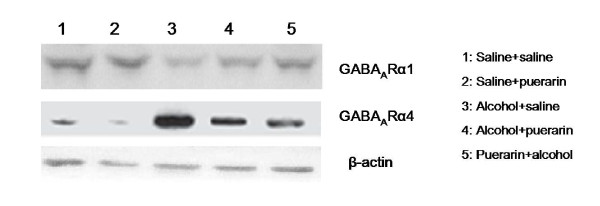
Representative western blot of protein expression of GABAAR α1 and α4 subunit.